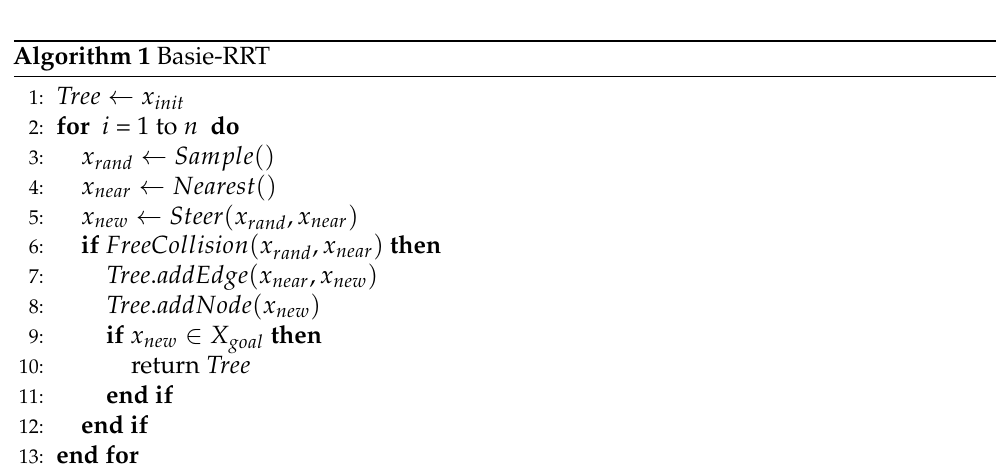
Figure 1. Expand of